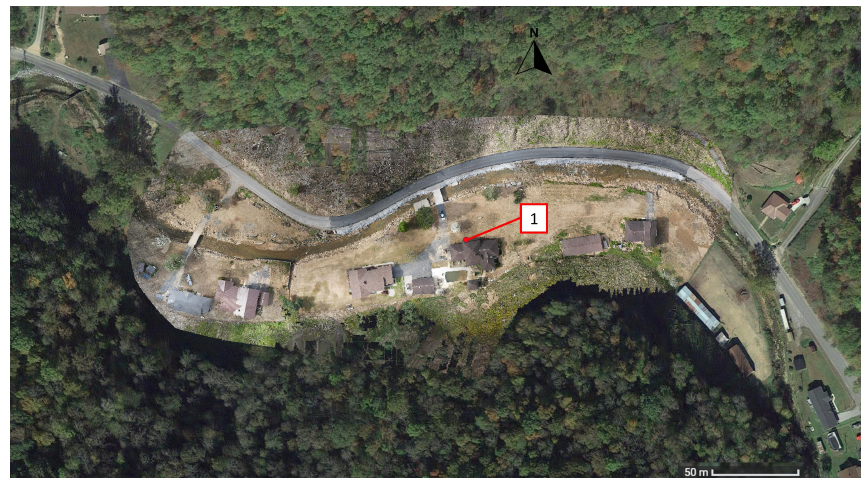
Figure 10. The first flood depth measurement location is marked with the label ’1’ on an orthophoto overlaid on satellite imagery. This measurement was taken at one of the houses along Guesses Fork Road.